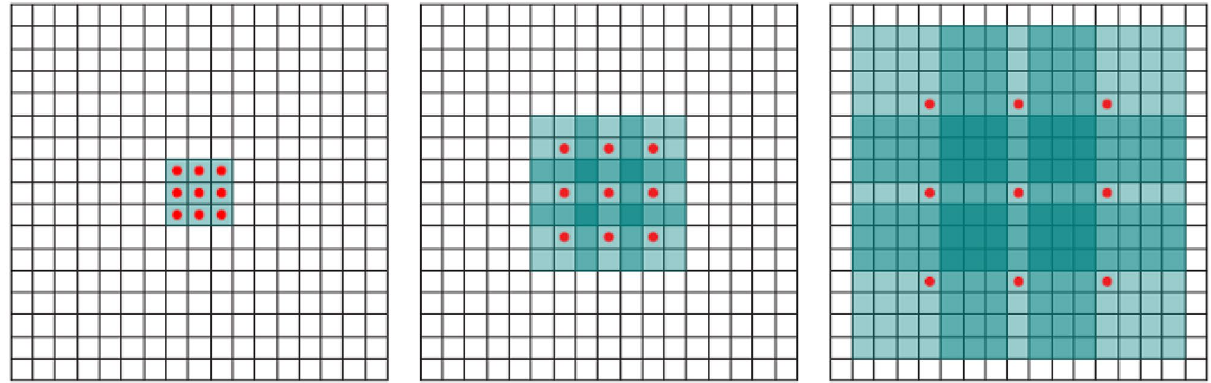
Figure 3. Schematic representation of dilated convolutions with dilation rate l, l = 1 (left), l = 2 (Middle), l = 4 (Right).